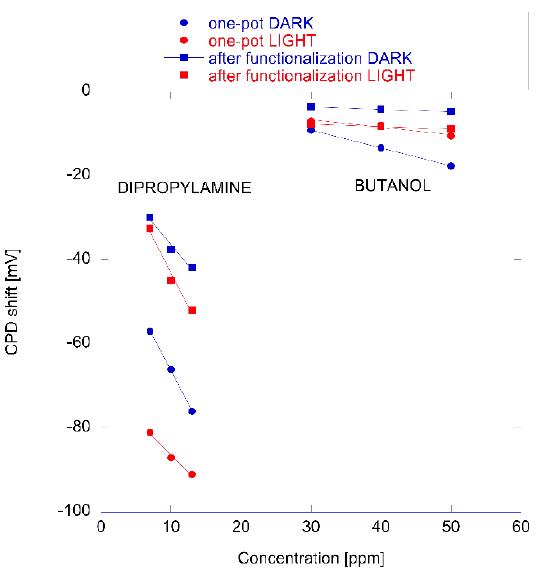
Figure 6. Variation of contact potential difference (CPD) in one-pot prepared material and in after-growth functionalized ZnO. The change of CPD is due to the exposure to dipropylamine and butanol and it is measured in dark and light conditions. Data from reference [22].